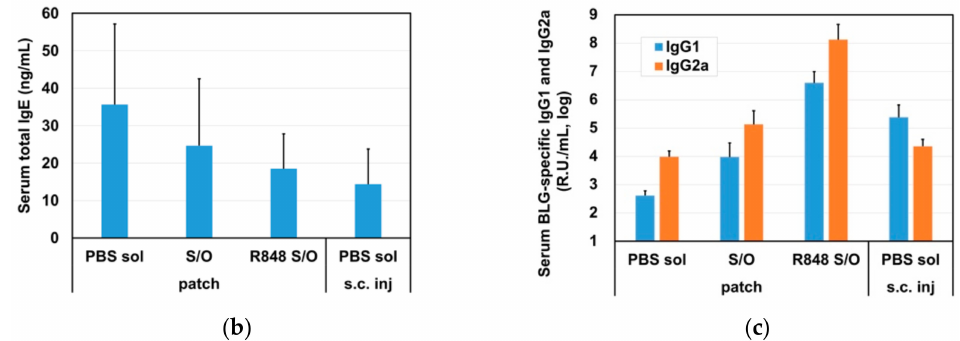
Figure 3. Serum antibody responses after antigen immunotherapy. ( a ) Schematic of the